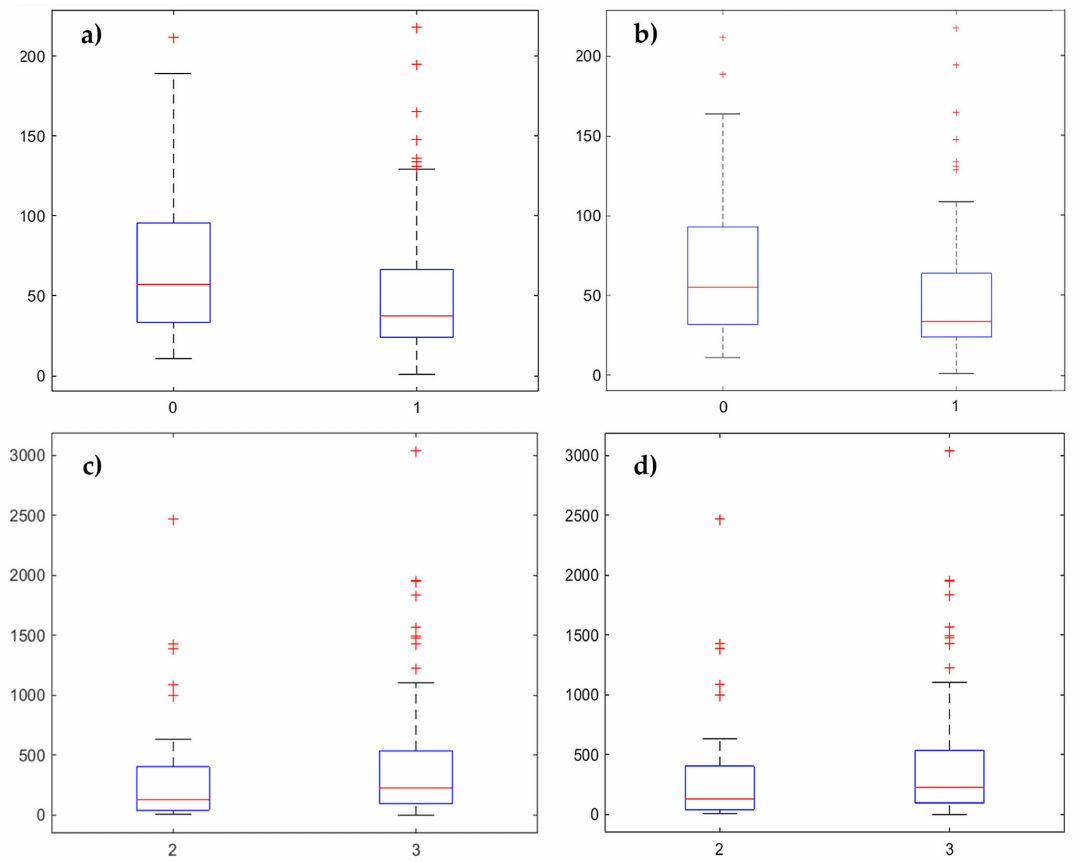
Figure 2. Box plots ( a , b ) comparing the median of tumor T-cell infiltration by using di ff erent percentiles to separate patients into two groups. Only the lowest p -values are shown in this composite figure. ( a ) CD3 + immune cell infiltration grouped by the 45th percentile (cut-o ff : 176 cells / mm 2 ) ( p = 0.011). ( b ) CD8 + immune cell infiltration grouped by the 50th percentile (cut-o ff : 118 cells / mm 2 ) ( p = 0.014). Box plots comparing ( c , d ) the median of tumor T-cell infiltration by using G2 versus G3 to separate patients into two groups. ( c ) CD3 + immune cell infiltration ( p = 0.043) and ( d ) CD8 + immune cell infiltration ( p =